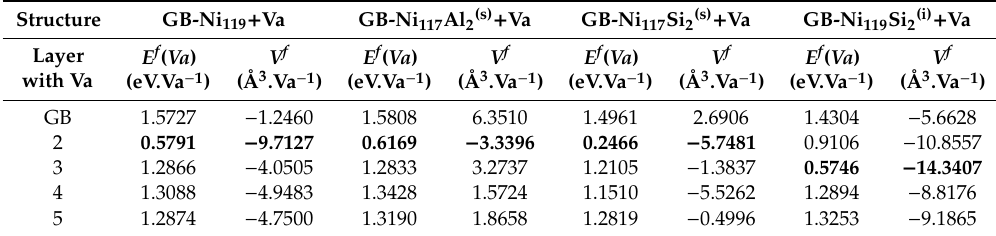
Table 6. Energy and volume e ff ects associated with vacancy formation in various layers of GB-Ni 119 +